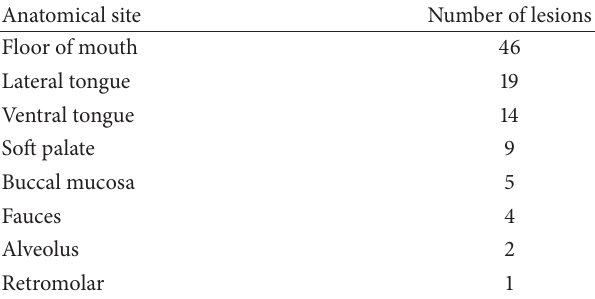
Table 1: Anatomical site of PMD